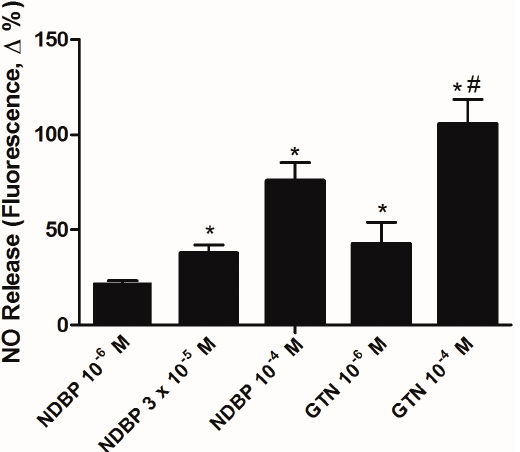
Figure 3. Nitric oxide generation by NDPB in vascular smooth muscle cells. * p < 0.05 versus basal fluorescence; # versus NDBP (10 − 6 M) and NDBP (3 × 10 − 5 M). Values are shown as mean ±